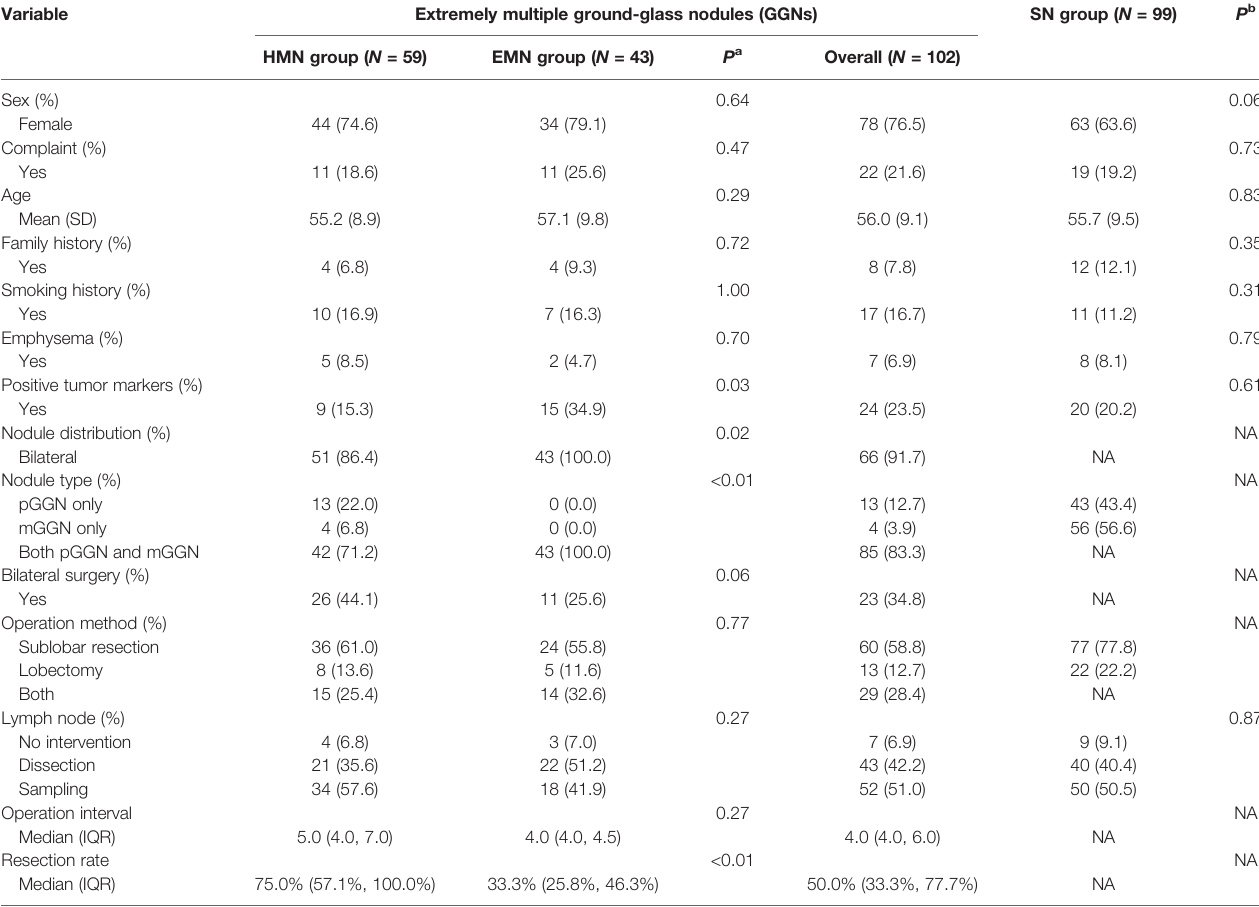
TABLE 1 | Clinical characteristics of the patients. Variable Extremely multiple ground-glass nodules